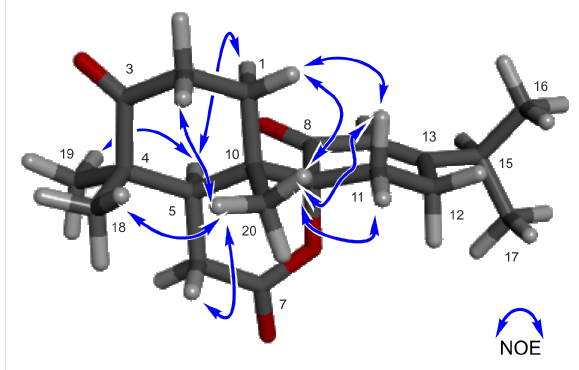
Figure 2: Selected 1 H– 1 H COSY and HMBC correlations for decan- drinin ( 1 ).